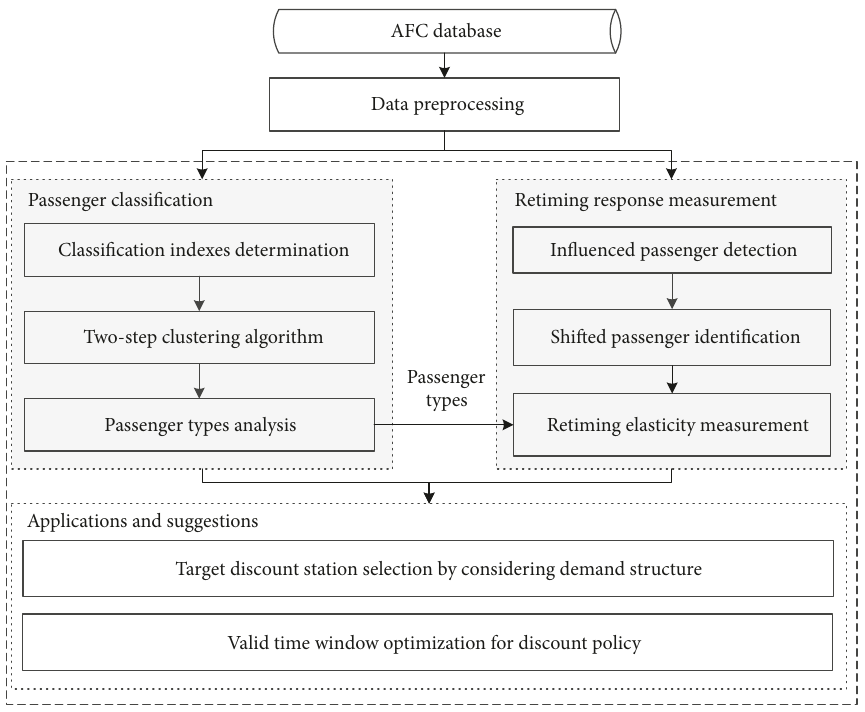
Figure 1: Framework for studying passengers’ retiming responses to the prepeak discount